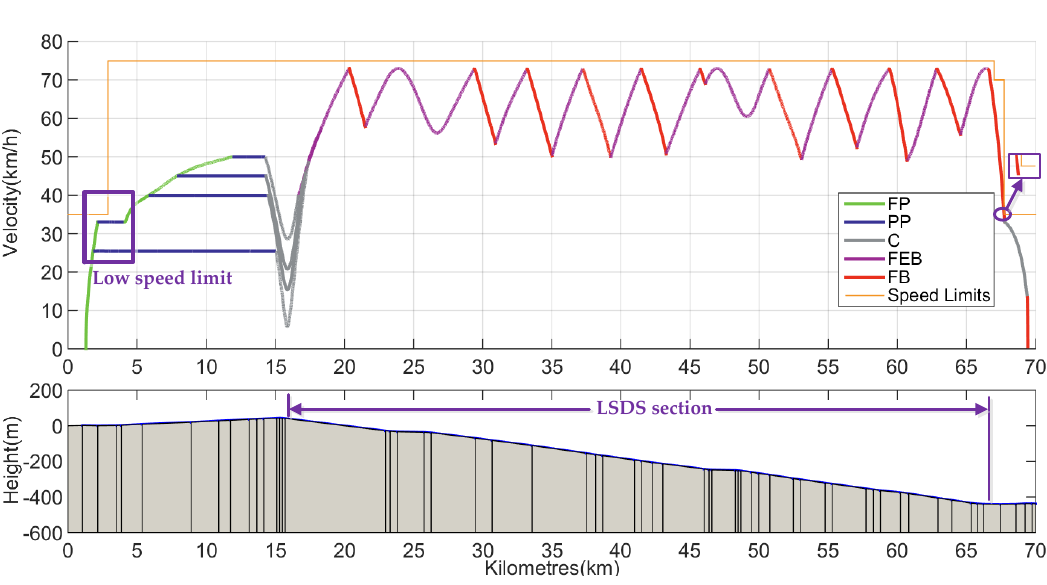
Table 1. Parameters of the freight train in the simulation.